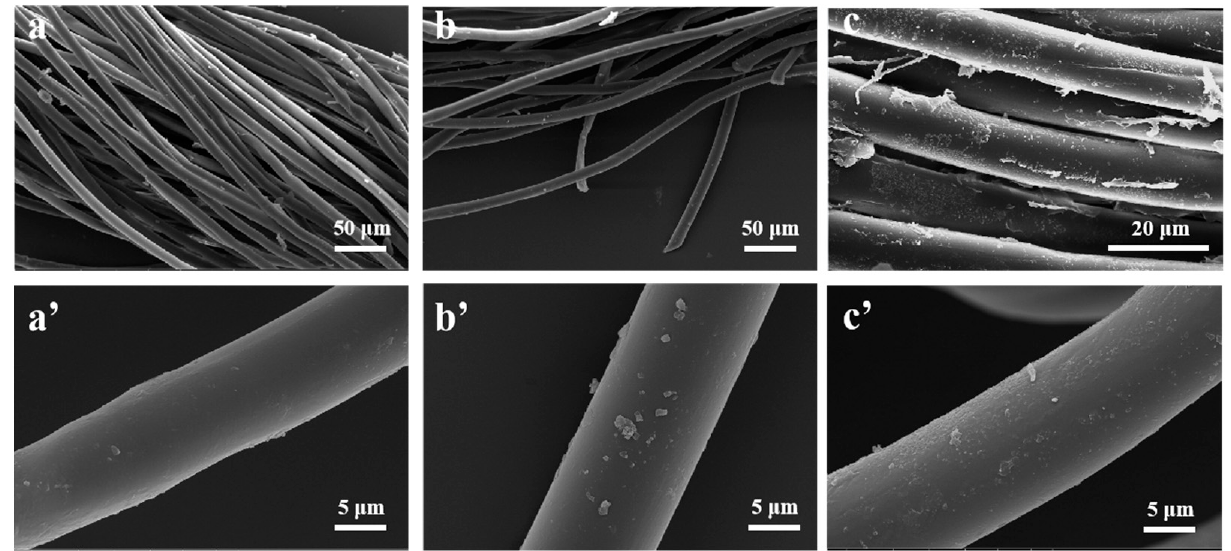
Figure 7. SEM images of ( a , a’ ) the pristine PET, ( b , b’ ) CSMs, and ( c , c’ ) HMs finished PET fabrics.